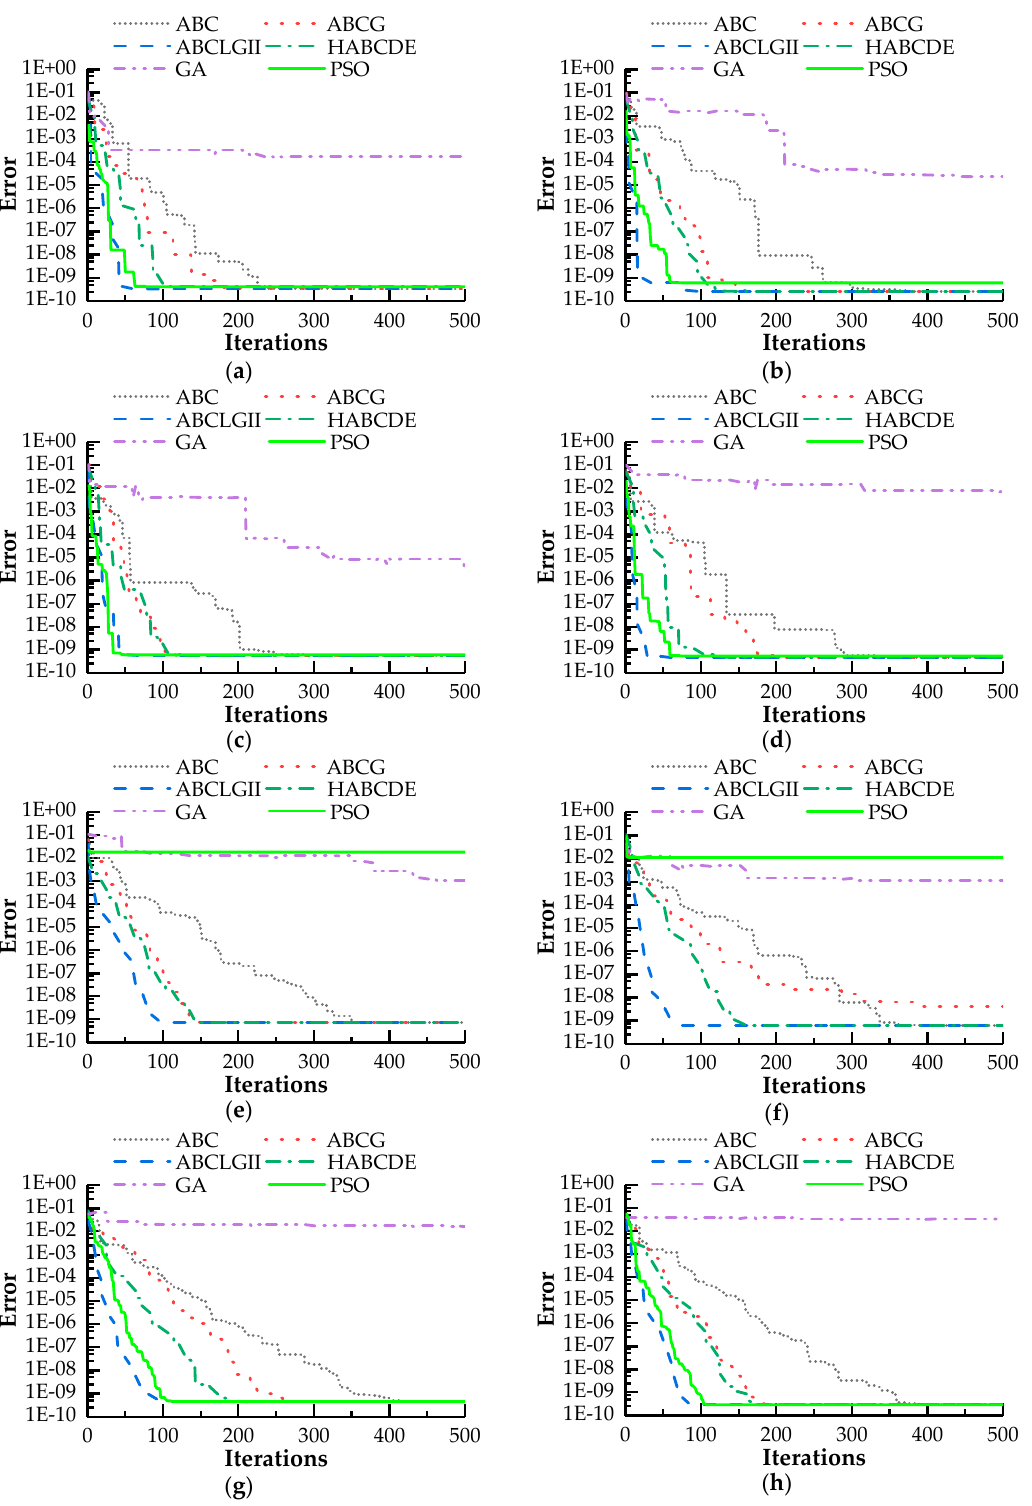
Figure 12. Iteration process of damage identification for cases 1 to 4: ( a ) case 1: slab 1; ( b ) case 1: slab 3; ( c ) case 2: slab 2; ( d ) case 2: slab 4; ( e ) case 3: slab 2; ( f ) case 3: slab 3; ( g ) case 4: slab 1; ( h ) case 4: slab 2.